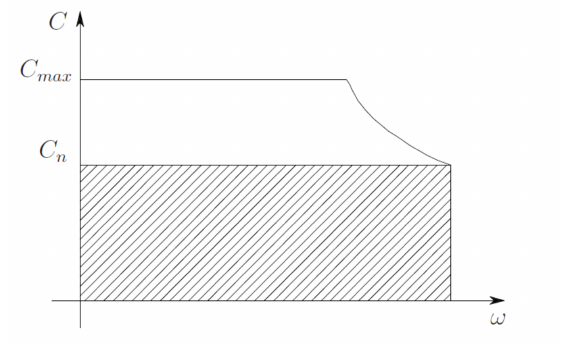
Figure 8. The Torque-speed curve of a brushless